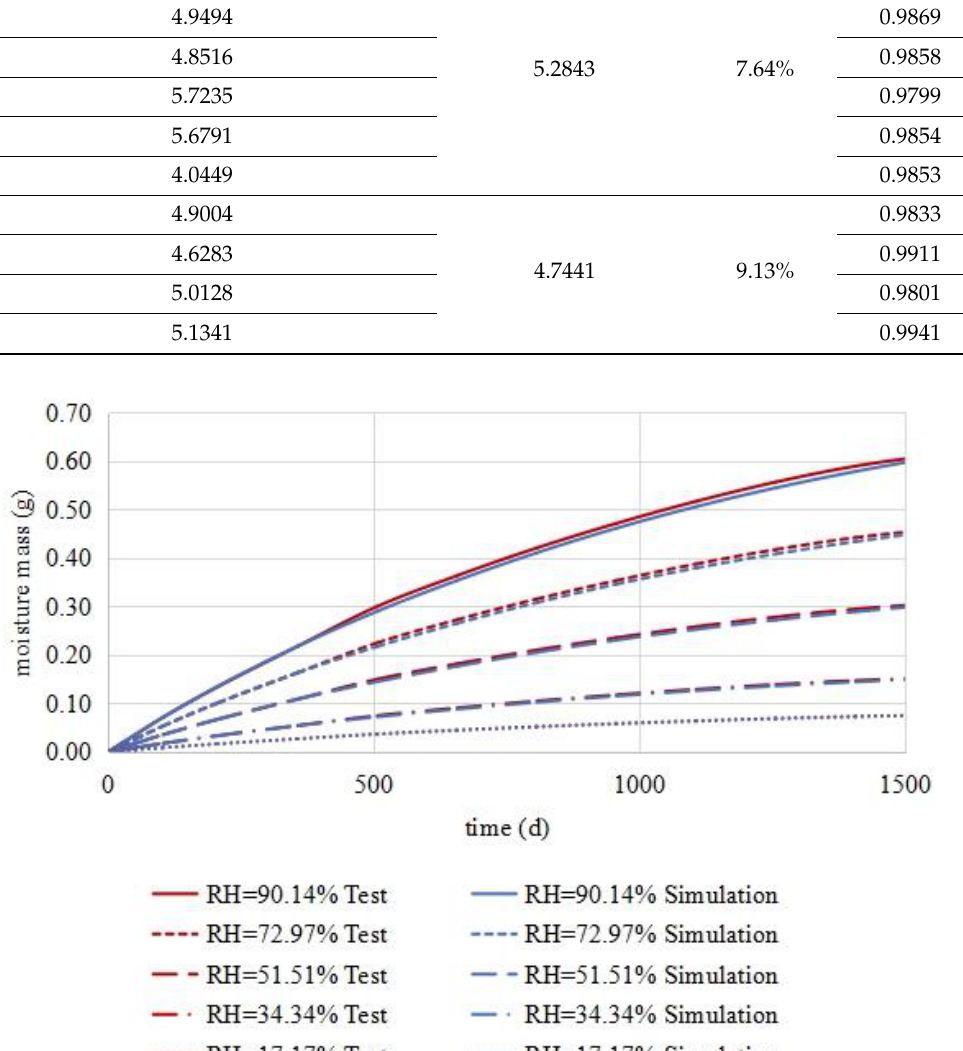
Figure 12. Comparison of the simulation results and the test results.